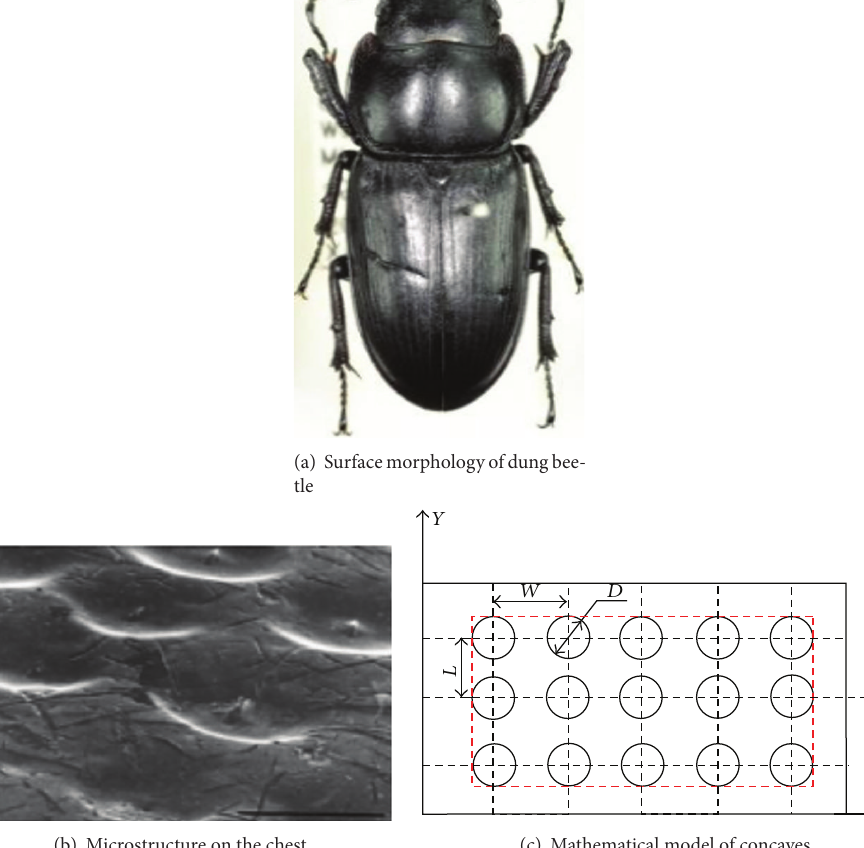
Figure 11: Nonsmooth surfaces of dung beetle.